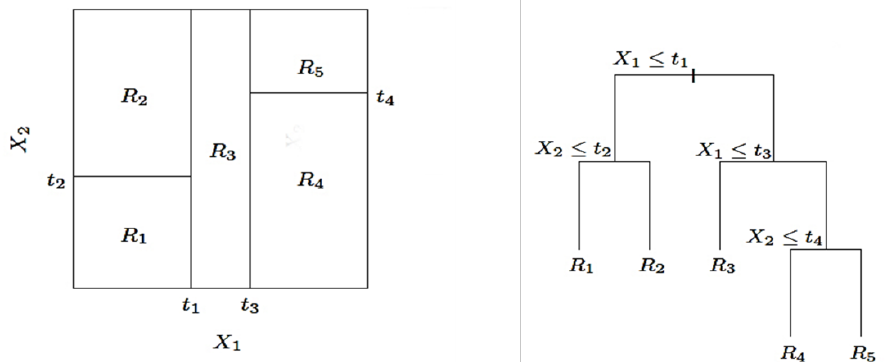
Figure 3. Partitions and CART. Left scheme shows a partition of a two-dimensional feature space by recursive binary splitting, as used in CART, applied to some fake data. X 1 and X 2 are sample features, R i is the i - th region of the features’ space. Right panel shows the tree corresponding to the partition. The variable t is a generic parameter.